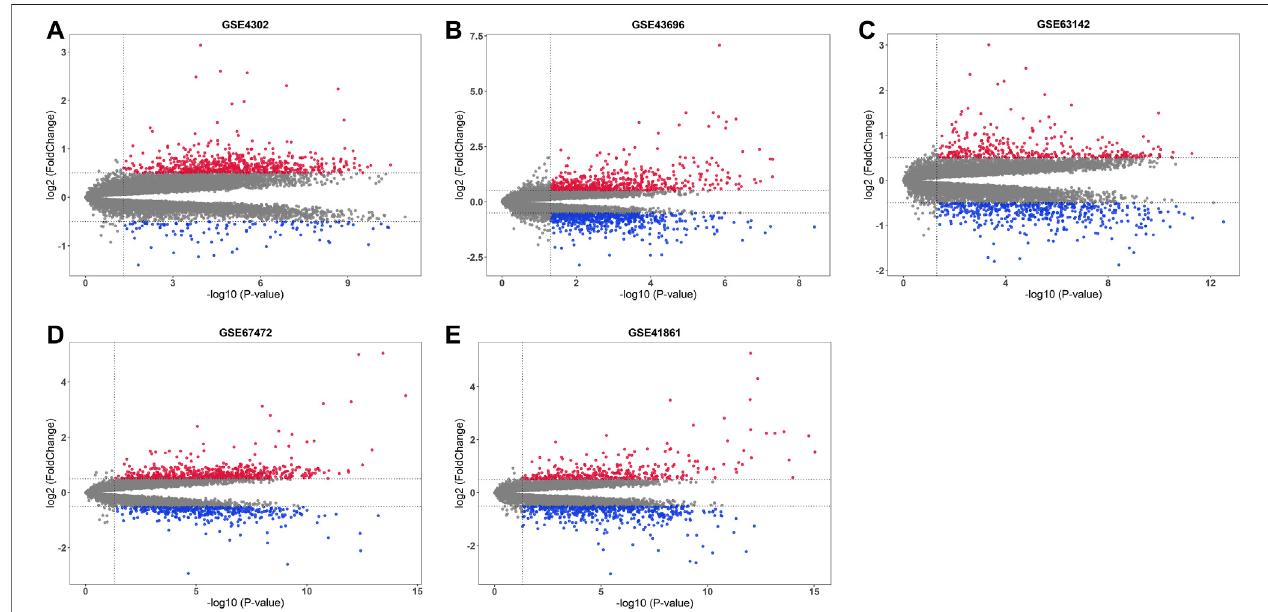
FIGURE2| Volcanoplotsof fi vemRNAmicroarraydatasets.Theupregulatedgenesweremarkedinred,whilethedownregulatedgenesweremarkedinblue.The gray dots represented genes with no signi fi cant difference. (A) GSE4302; (B) GSE43696; (C) GSE63142; (D) GSE67472; (E) GSE41861.